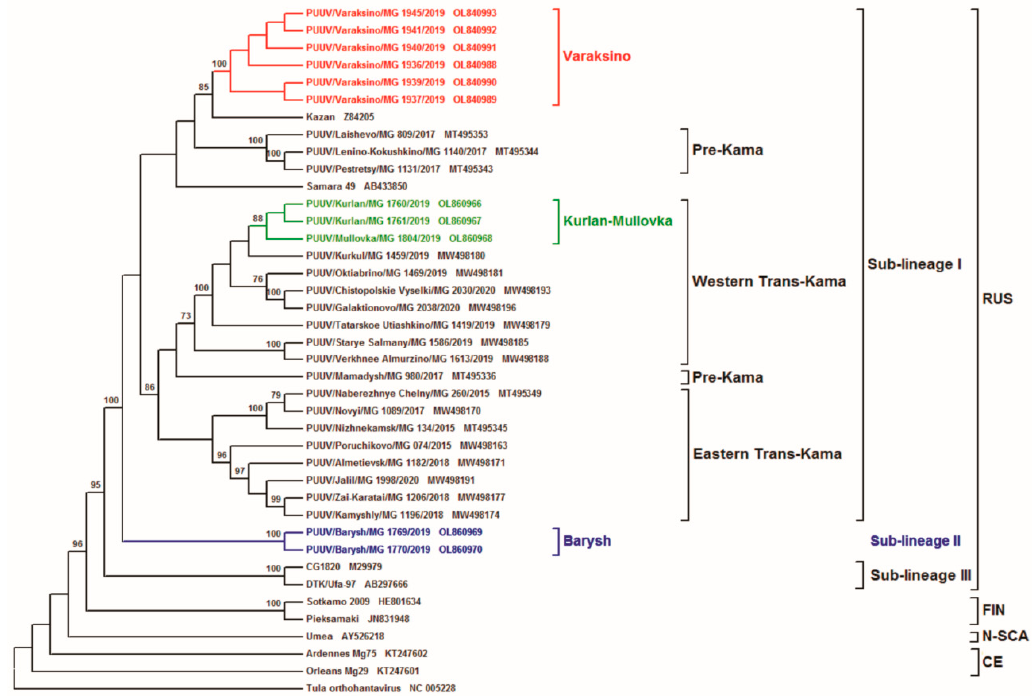
Figure 3. Phylogenetic tree calculated based on the partial (1014 bp) of PUUV M segment sequences obtained from bank voles trapped in ULR and UR. The sequence position was aligned against GenBank Kazan, accession number Z84205.